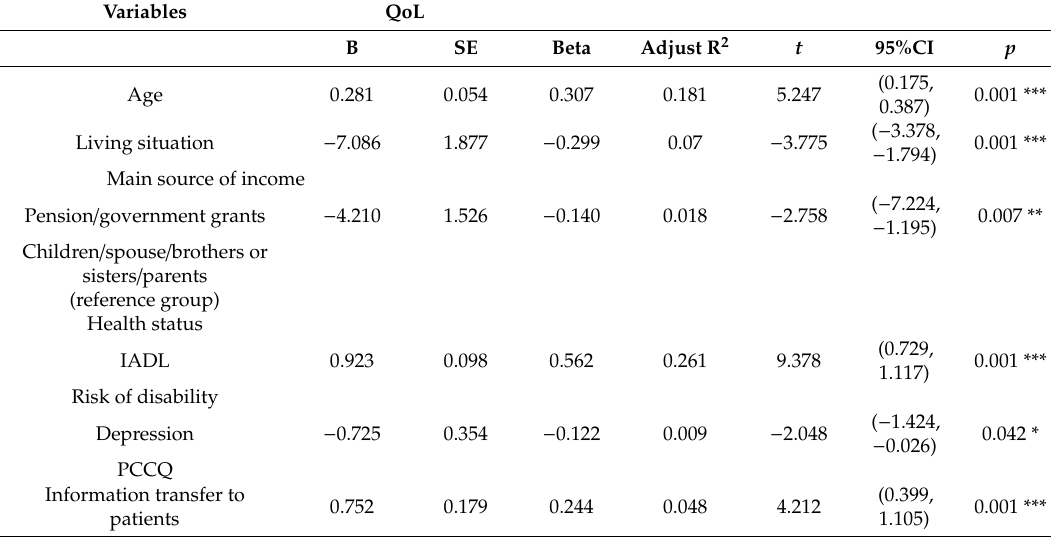
Table 4. Correlations between sociodemographic characteristics, health status, risk of disability, continuity of care, and quality of life among patients with coronary heart disease (N =